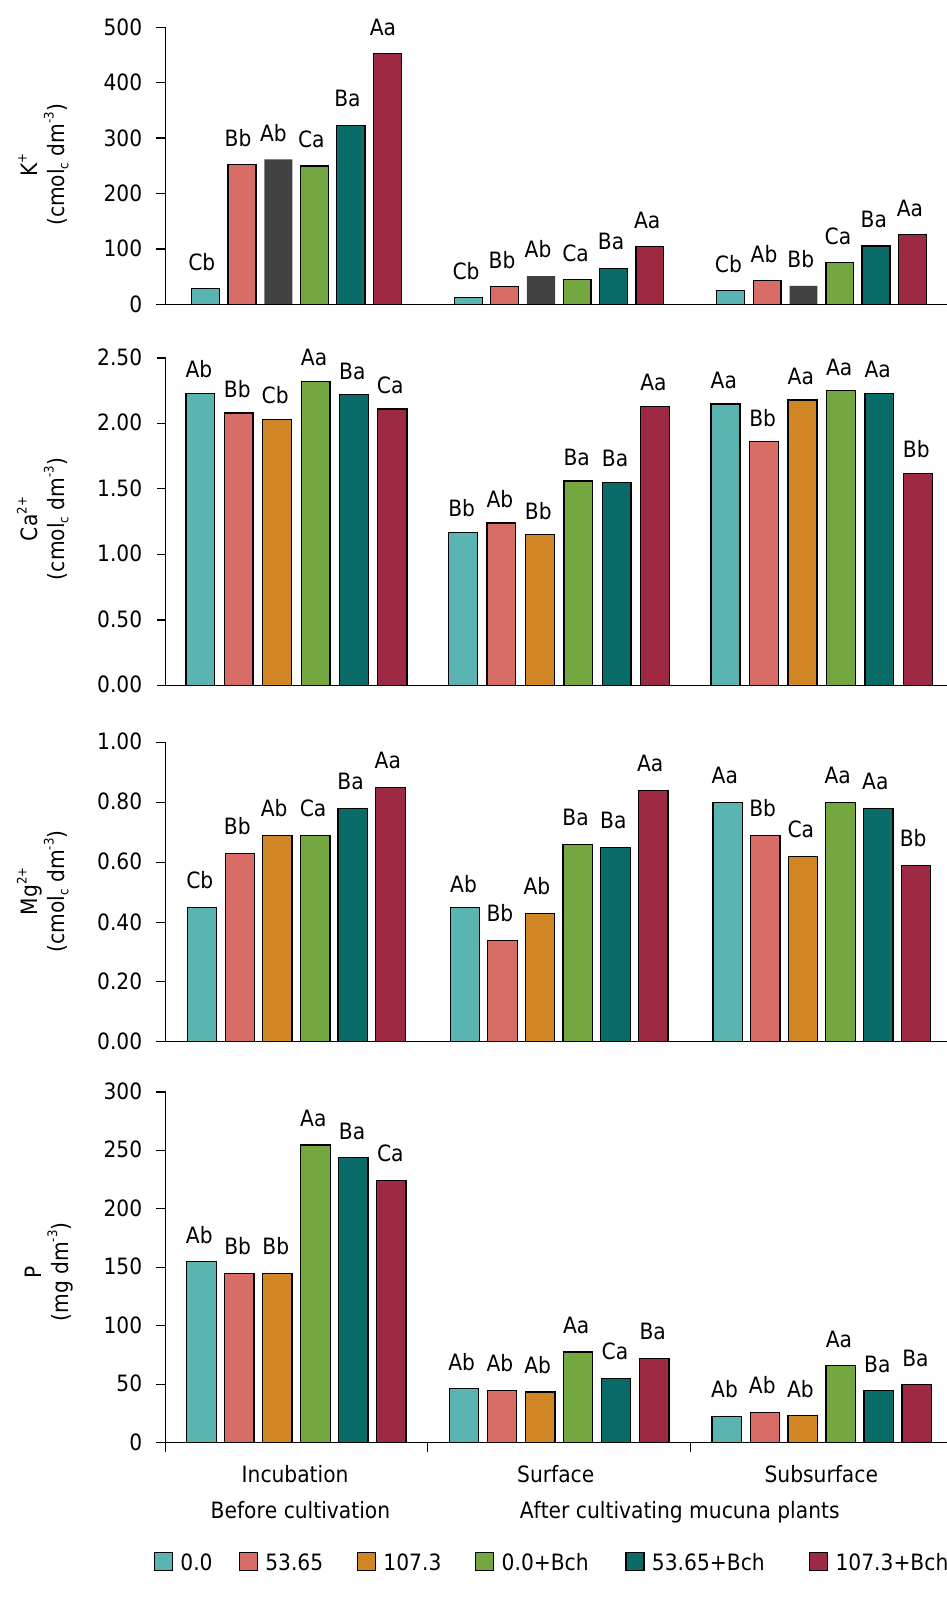
Figure 3. Potassium (a), Ca 2+ (b), Mg 2+ (c), and P contents (d) in the incubated soil (during 20 days) and the surface and subsurface soils (after the mucuna cultivation) treated with or without biochar associated with three doses of K (mg dm -3 ). Differences between the three K doses for treatments with or without biochar are indicated by capital letters. Differences between treatments with or without biochar at each dose of K are indicated by lowercase letters, both by the Tukey’s test at 5 % (mean of 6